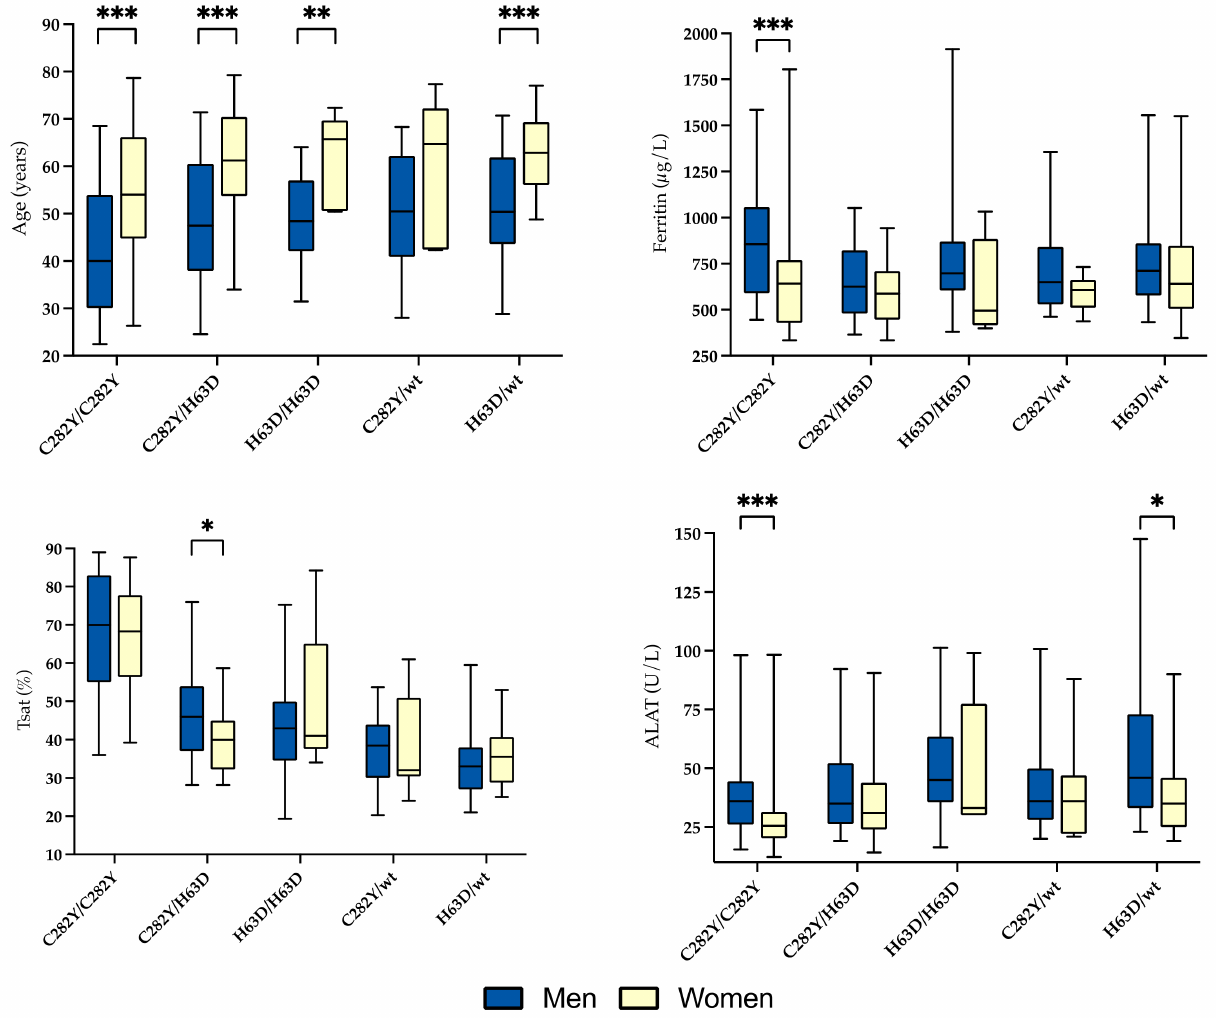
Figure 2. Genotypic differences in age, ferritin, transferrin saturation (Tsat) and alanine aminotransferase (ALAT) levels by gender. Boxes represent the 25th and 75th percentile and whiskers represent the 5th and 95th percentile. Significant p -values are indicated in figures with asterisks: * ≤ 0.05; ** ≤ 0.01; *** ≤